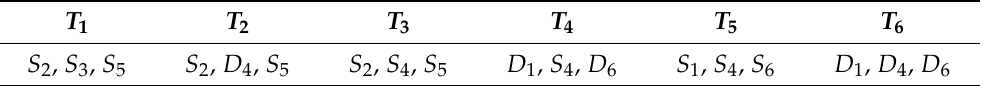
Table 3. Conduction of switches in different time intervals in BFC2DC